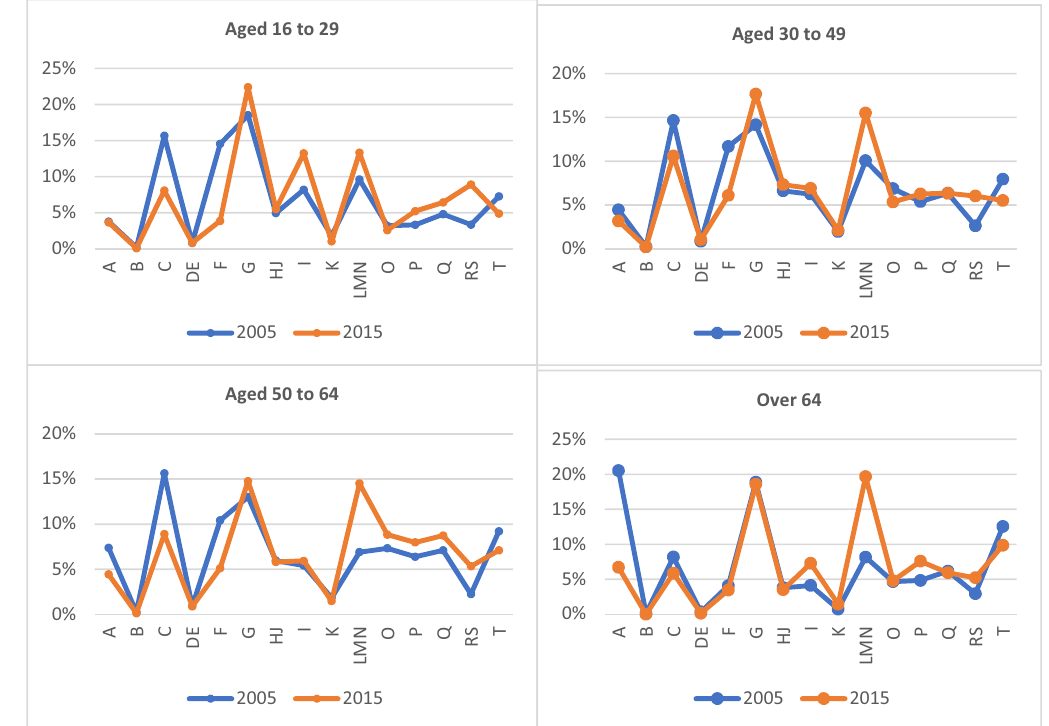
Figure 2: Employment distribution among age groups ( percentages ) . Source: compiled by